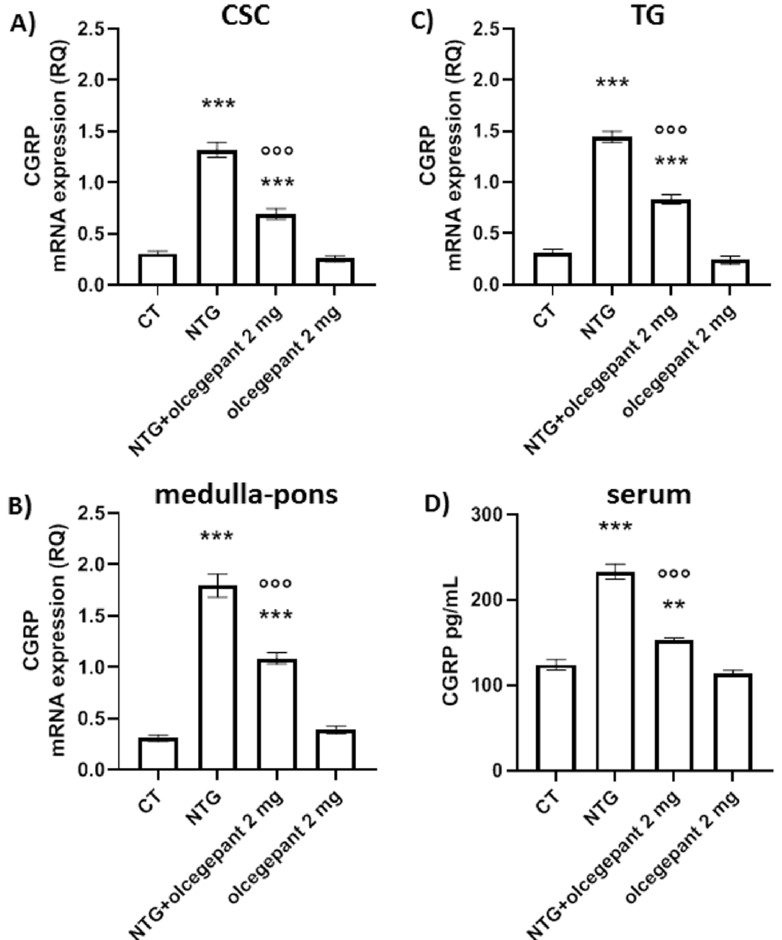
Figure 4. CGRP mRNA levels expressed as relative quantification (RQ) in cervical spinal cord (CSC)